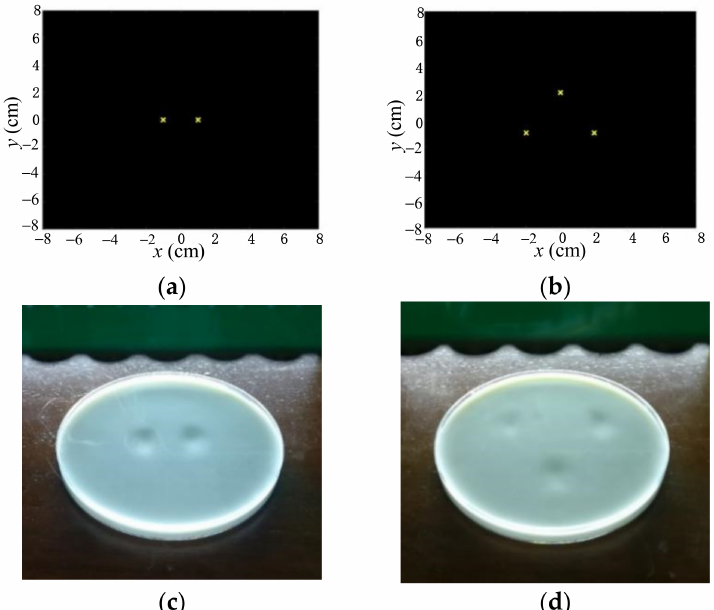
Figure 12. Ultrasound pressure with multiple points on liquid surface. ( a ) Desired two-point focuses. ( b ) Desired three-point focuses. ( c ) Two-point pressure distribution. ( d ) Three-point pressure distribution.